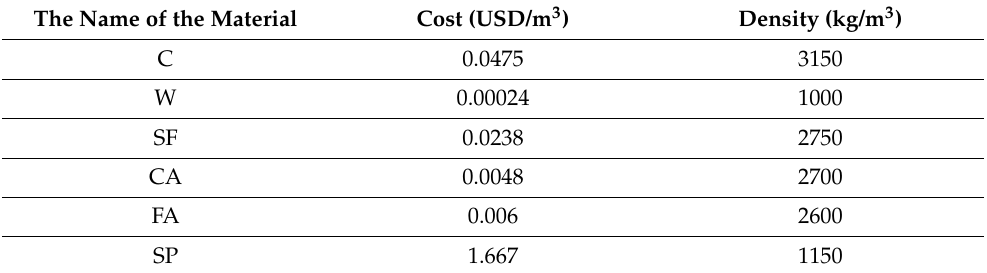
Table 2. Cost and density of each